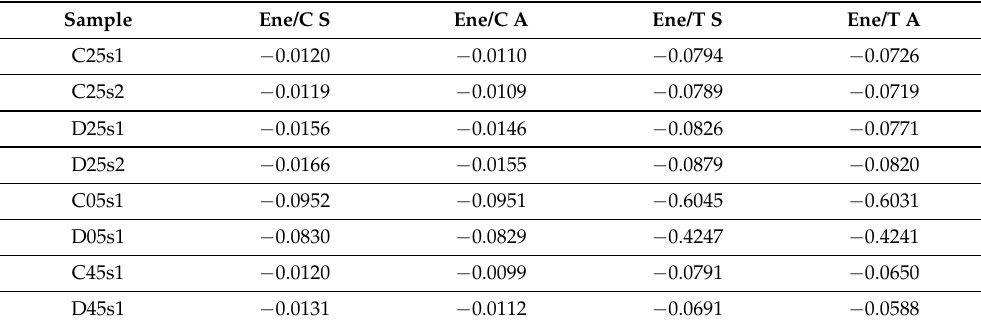
Table 5. Linear regression coefficients of energy depending on cycle no. (denoted as /C) or time (denoted as /T) in days considering the second capacity test (denoted as S) or all the capacity tests (denoted as A) for individual